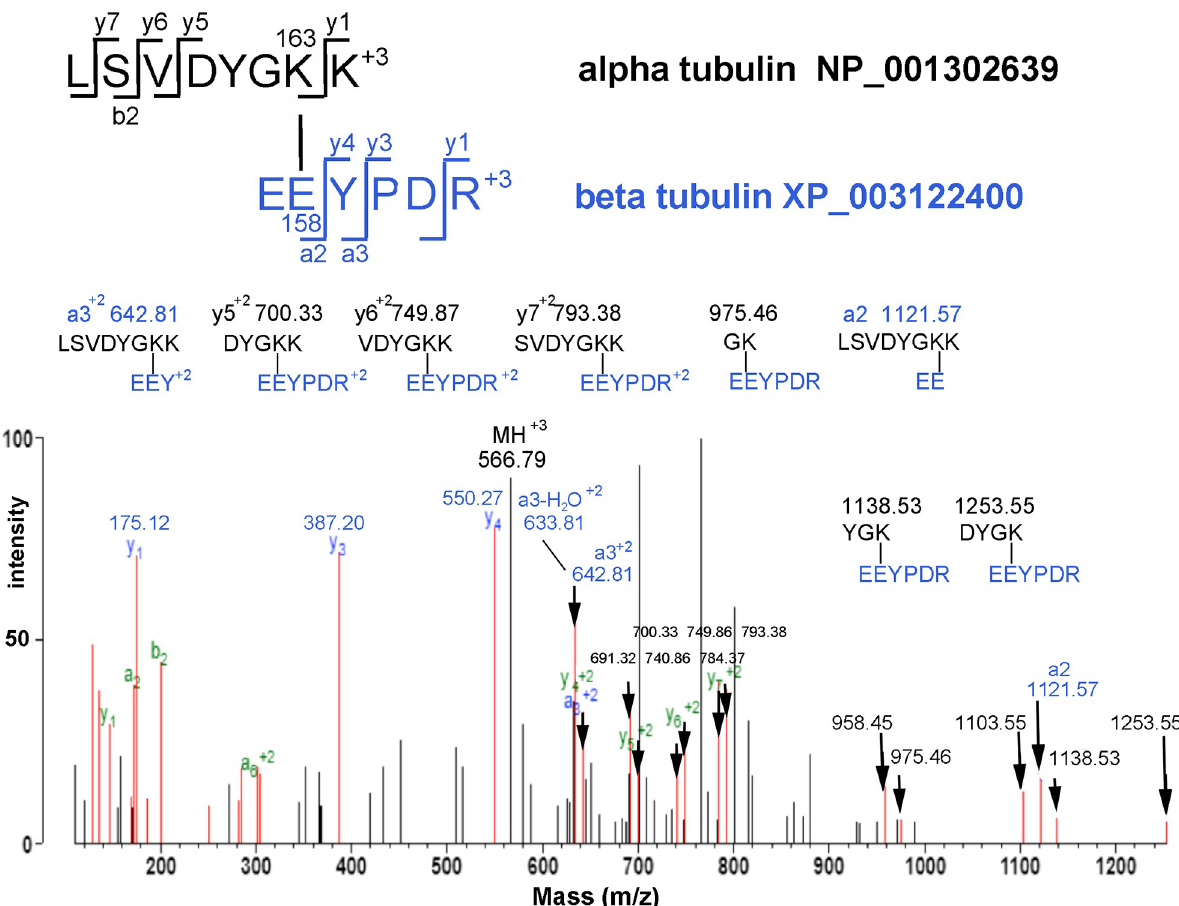
Fig 6. MS/MS spectrum of an isopeptide crosslink between K163 of tubulin alpha-1A and E158 of tubulin beta-4B induced by treatment of MAP-rich tubulin Sus scrofa with 100 μ M chlorpyrifos oxon. The parent ion at 566.79 is in charge state +3. Arrows point to 14 crosslink-specific fragment ions. Structures are shown for 8 crosslink-specific fragment ions. Fragment ions from both peptides are present. The Protein Prospector score is 29.8 and the score difference is 6.2. The matched intensity is 47.1%. Unassigned, black peaks could not be fit to any sequence.